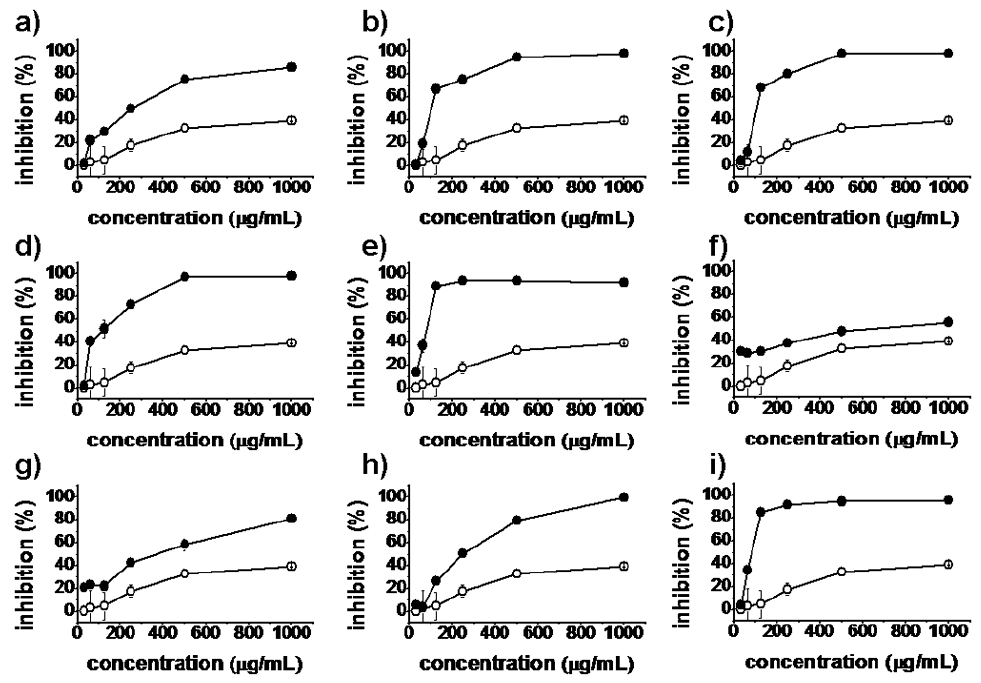
Figure 4. Inhibition percentages of 5a – i ( a – i , respectively) against HeLa cells ( 3 ) at concentrations of 31.25, 62.5, 125, 250, 500, and 1,000 μ g/mL. Matrine ( ), synthesized compounds ( ). Results are expressed as the mean ± SD of data obtained from three independent